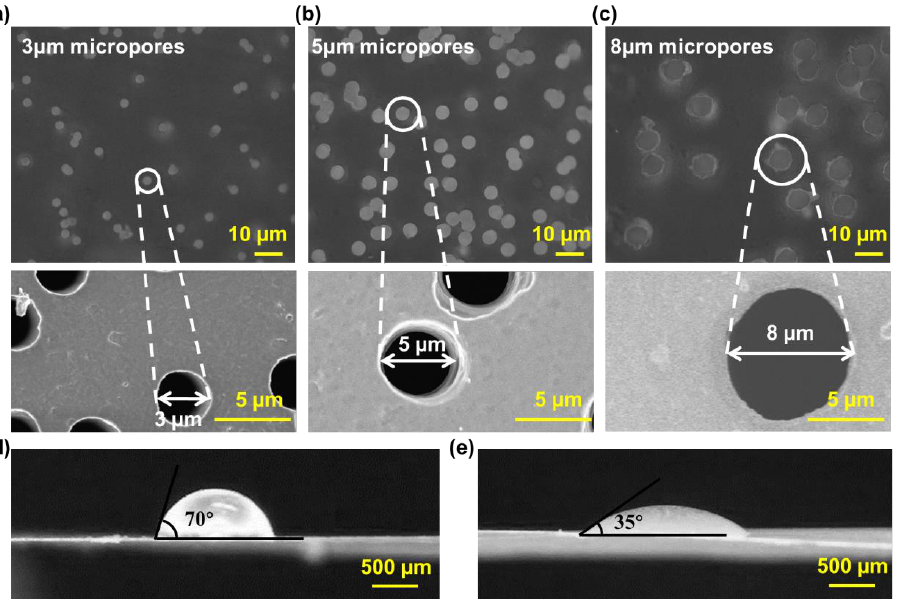
Figure 3. Morphology characterization of microporous membranes. ( a ) The micropores of 3 µm (po- rosity = 7.1%, thickness = 9 μm). ( b ) The micropores of 5 µm (porosity = 11.8%, thickness = 10 μm). ( c ) The micropores of 8 µm (porosity = 15.1%, thickness = 15 μm). ( d ) The 70° contact angle of the deionized water on the surface of untreated microporous membranes. ( e ) The 35° contact angle of thickness = 10 µ m).( c ) The micropores of 8 µ m (porosity = 15.1%, thickness = 15 µ m). ( d ) the deionized water on the surface of pretreated microporous membranes.